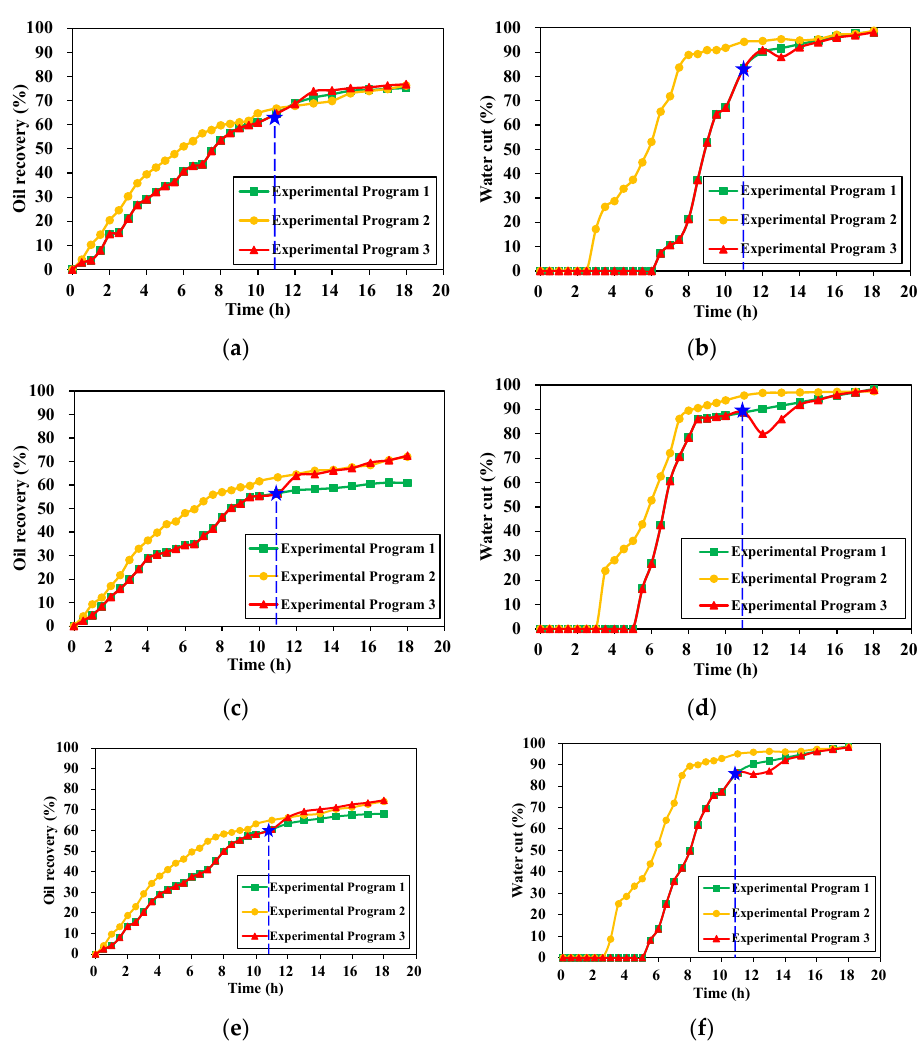
Figure 10. Schematic diagram of image recognition and processing; ( a ) upper plate recovery degree- time curve; ( b ) upper plate water cut-time curve; ( c ) lower plate recovery degree-time curve; ( d ) lower plate water cut-time curve ( e ) overall recovery degree-time curve ( f ) overall water cut-time curve. The blue dotted lines represent the cyclic alternating injection and production timing in Experimental Program